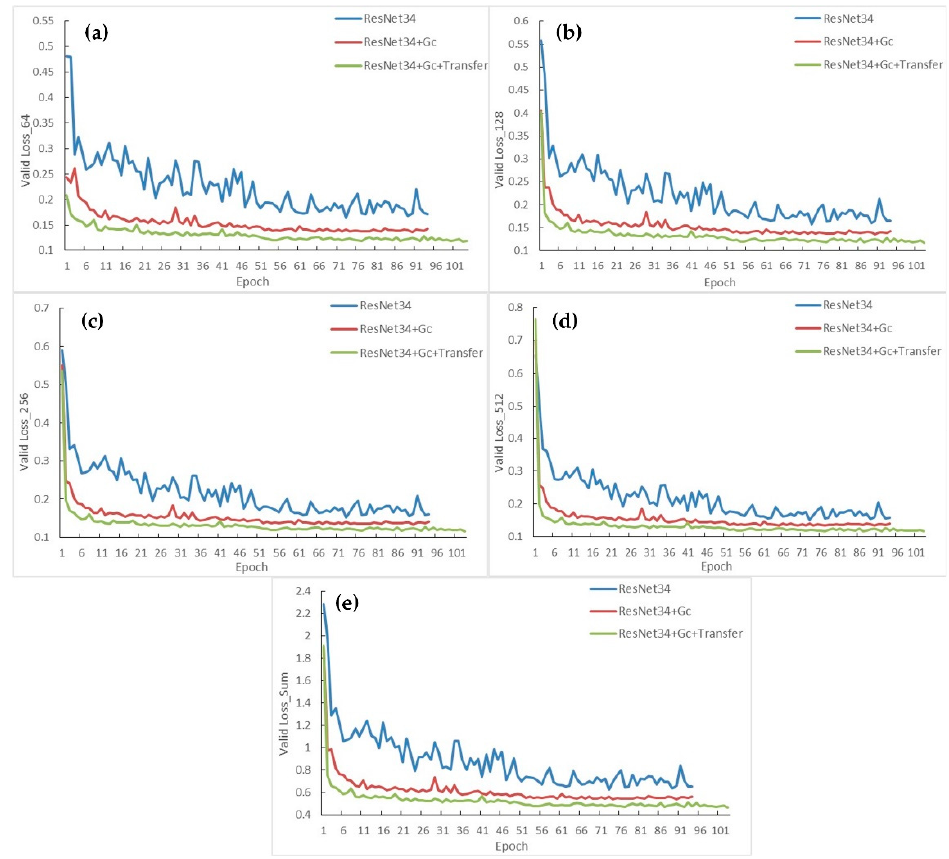
Figure 5. Loss value of validation from DeepGlobe dataset. Loss value of size ( a ) 64 × 64; ( b ) 128 × 128; ( c ) 256 × 256; ( d ) 512 × 512; and ( e ) sum of all scales. Table 4. The results of ablation experiments. The values in bold are the best.